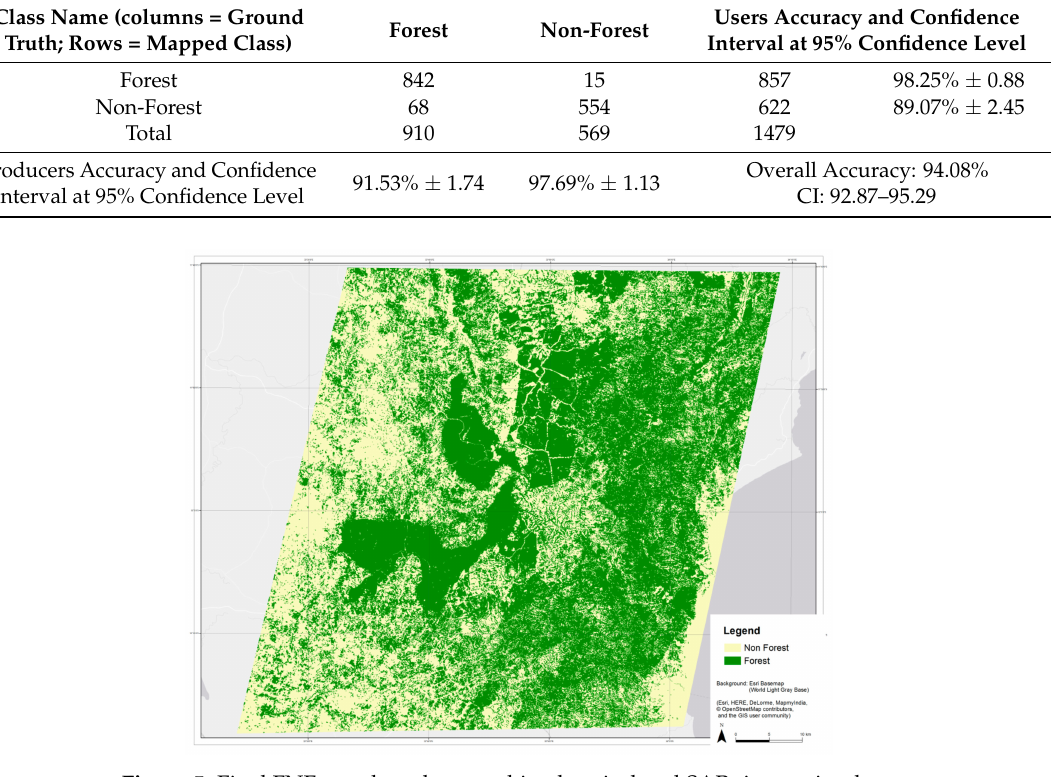
Figure 5. Final FNF map based on combined optical and SAR time series data.